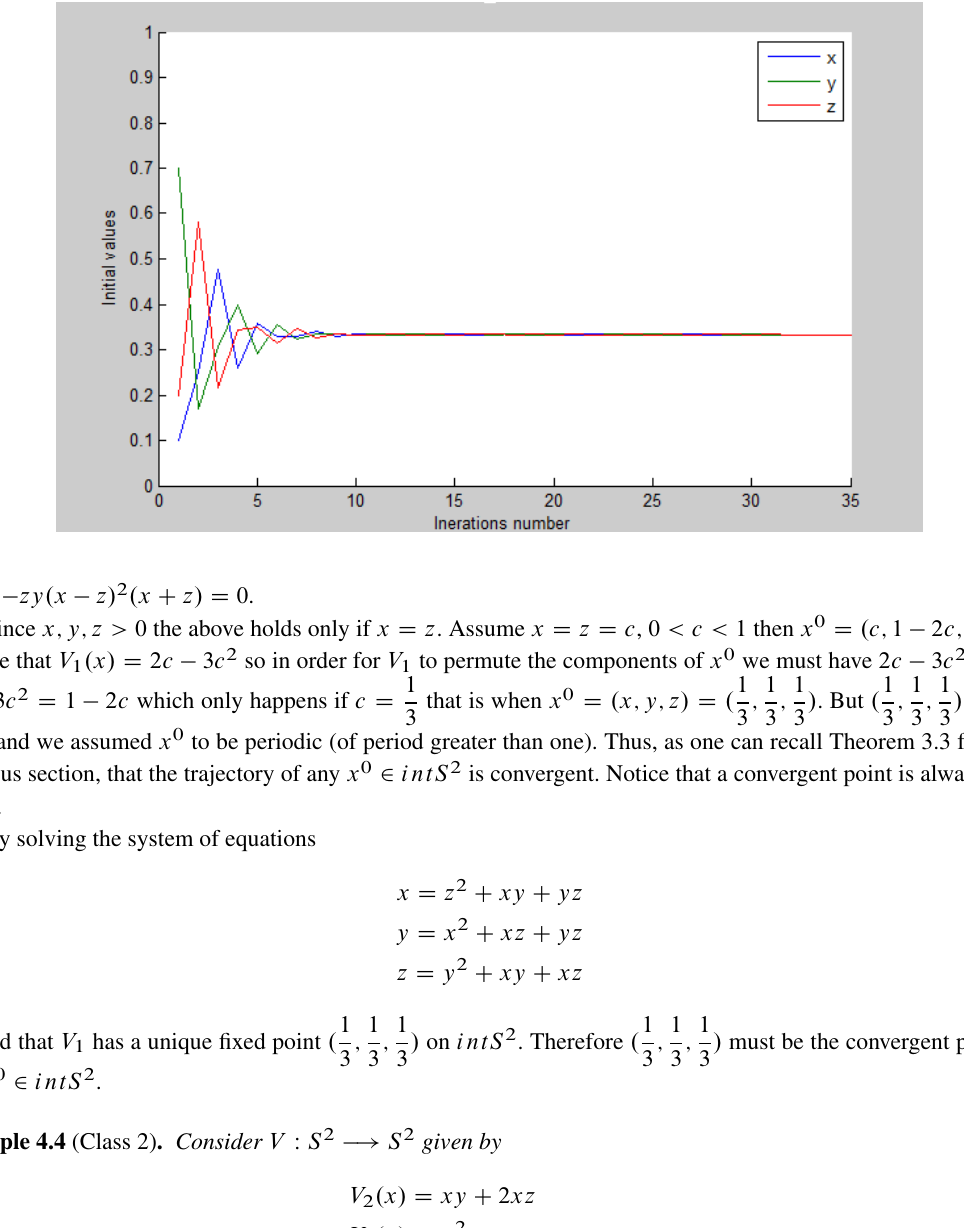
Fig. 1. The trajectory of operator V 1